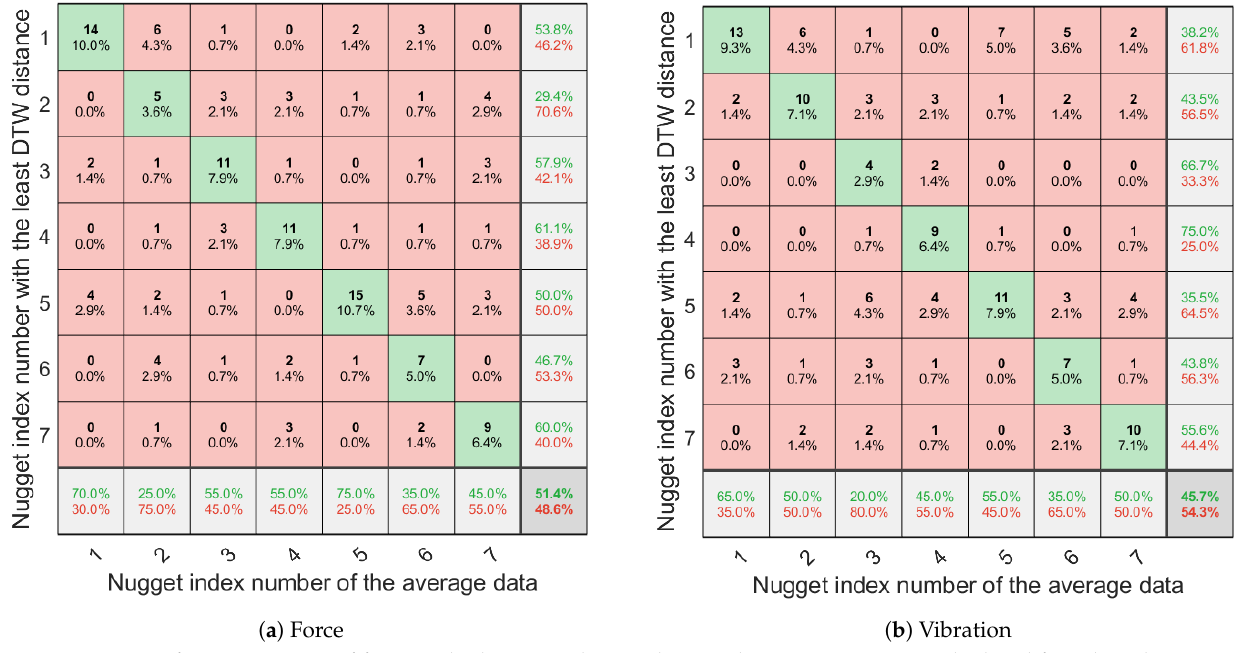
Figure 10. Confusion matrixes of force and vibration. The numbers and percentages were calculated for when the DTW distance in the average data for nuggets with the same coating was least compared to the DTW distances for the average data of other nuggets with different coatings. The green number indicates the percentage which the nugget index number with the least DTW distance and the nugget index number of the average data matched. The red numbers indicate the percentages that did not match. Table 5. F 1 scores of each nugget sample in Figure